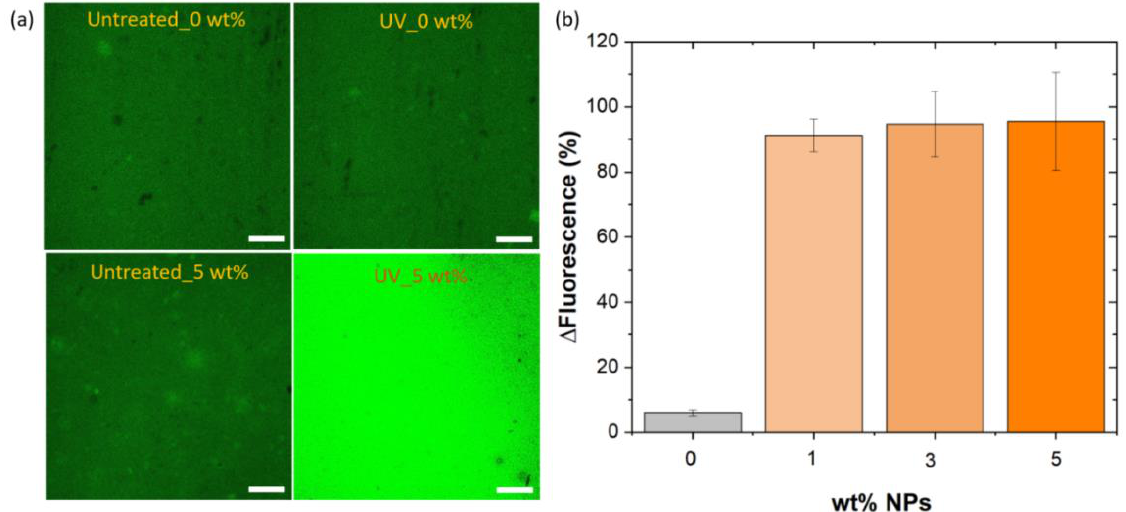
Figure 8. ( a ) CLSM images of the layered composite with 0 and 5 wt.% NP content, before and after the exposure to UV treatment. Scale bar 150 µm. ( b ) Variation of fluorescence detected in the different samples confocal microscopy images taken before and after UV treatment.